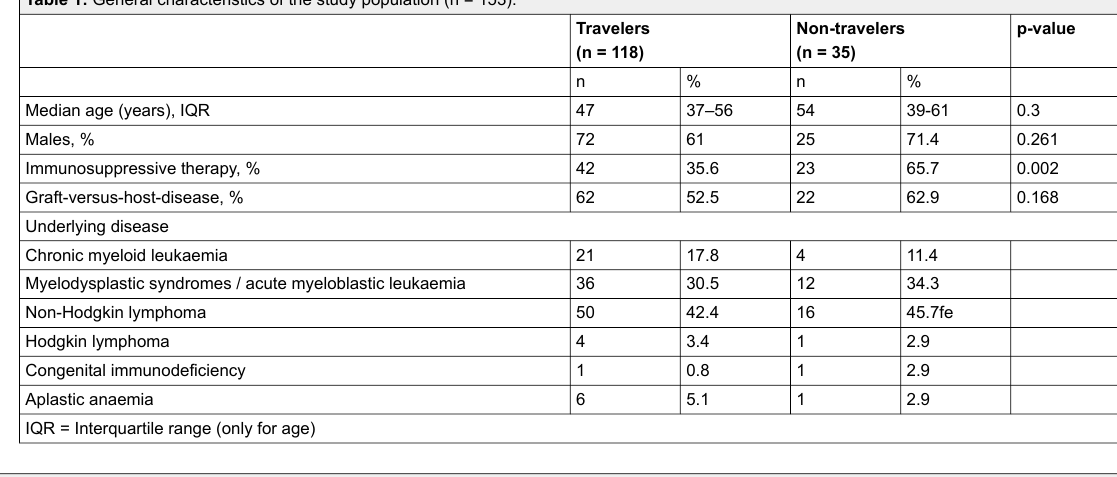
Table 2: Characteristics of 201 journeys performed by 118 patients according to the main destination.